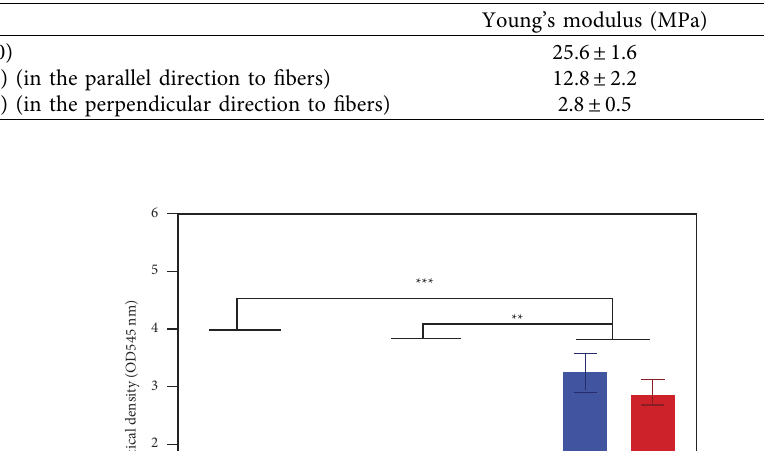
Table 2: Young’s modulus and elongation-at-break values of the scafolds.